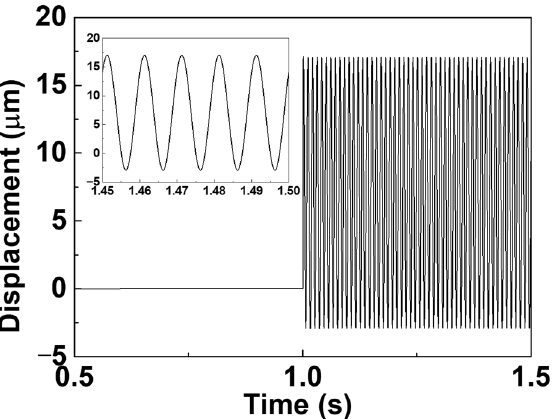
Figure 7. Axial displacement signal of the central node of the pressboard of group TEM11 in the time range 0.5 to 1.5 s (locally enlarged signal in time range 1.45 to 1.5 s in the subfigure.